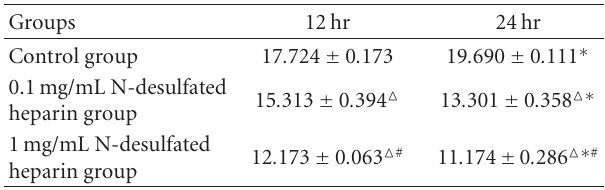
Table 2: bFGF expression of gastric cancer SGC-7901 cells